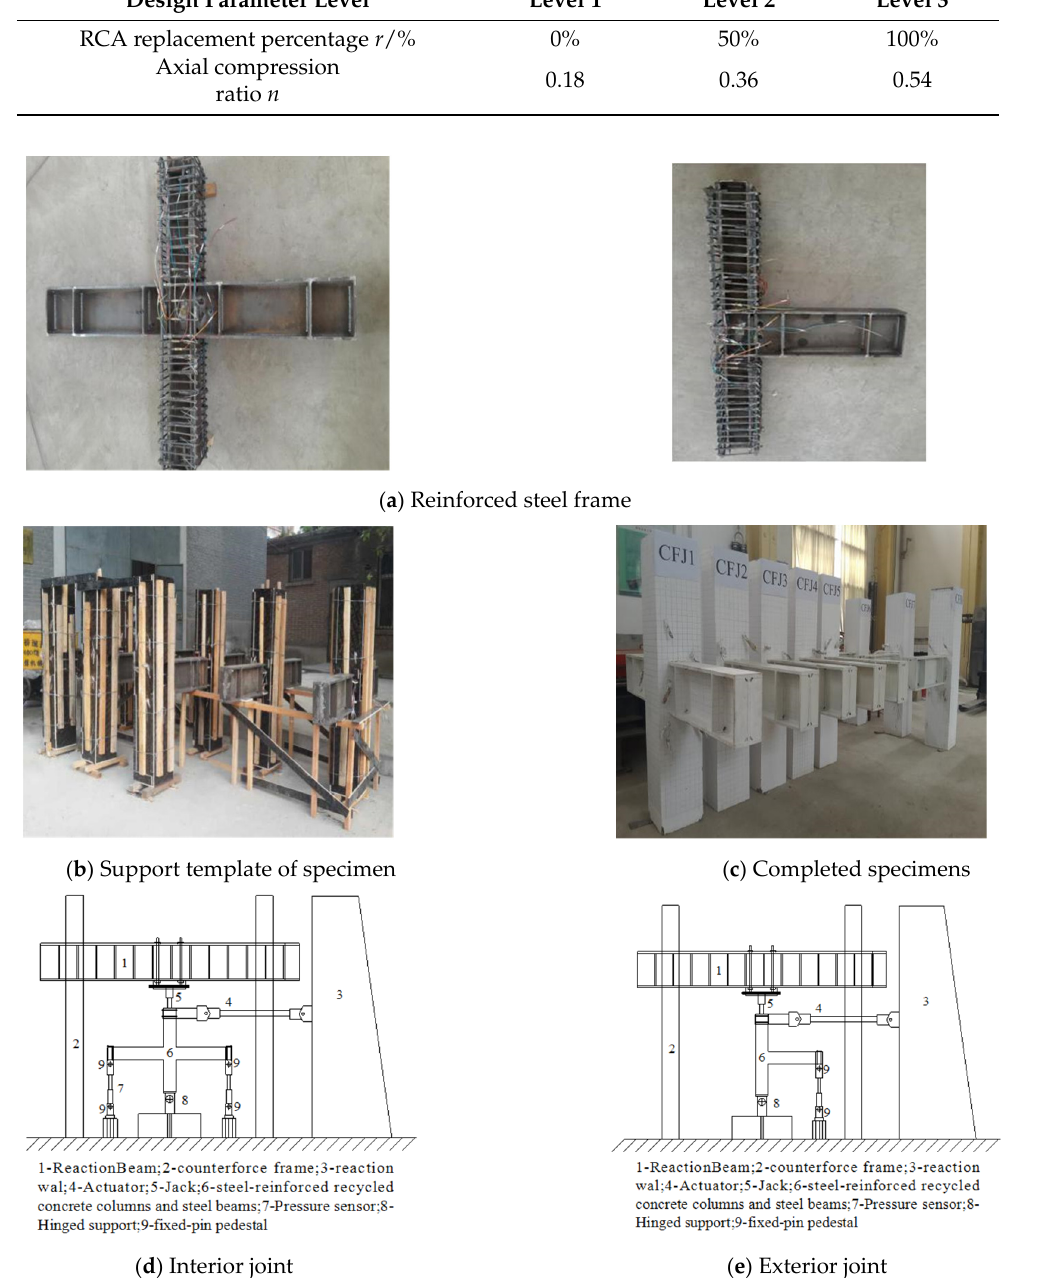
Figure 2. Schematic diagram of main manufacturing process and test device of test piece. Table 2. Mix ratio of RAC materials.